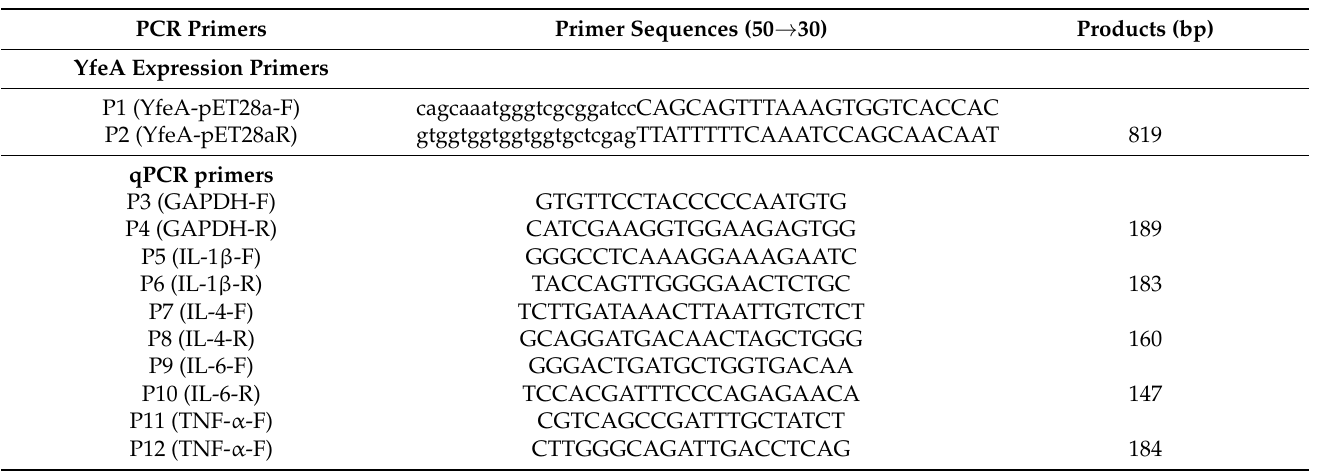
Table 1. Primers were used in this